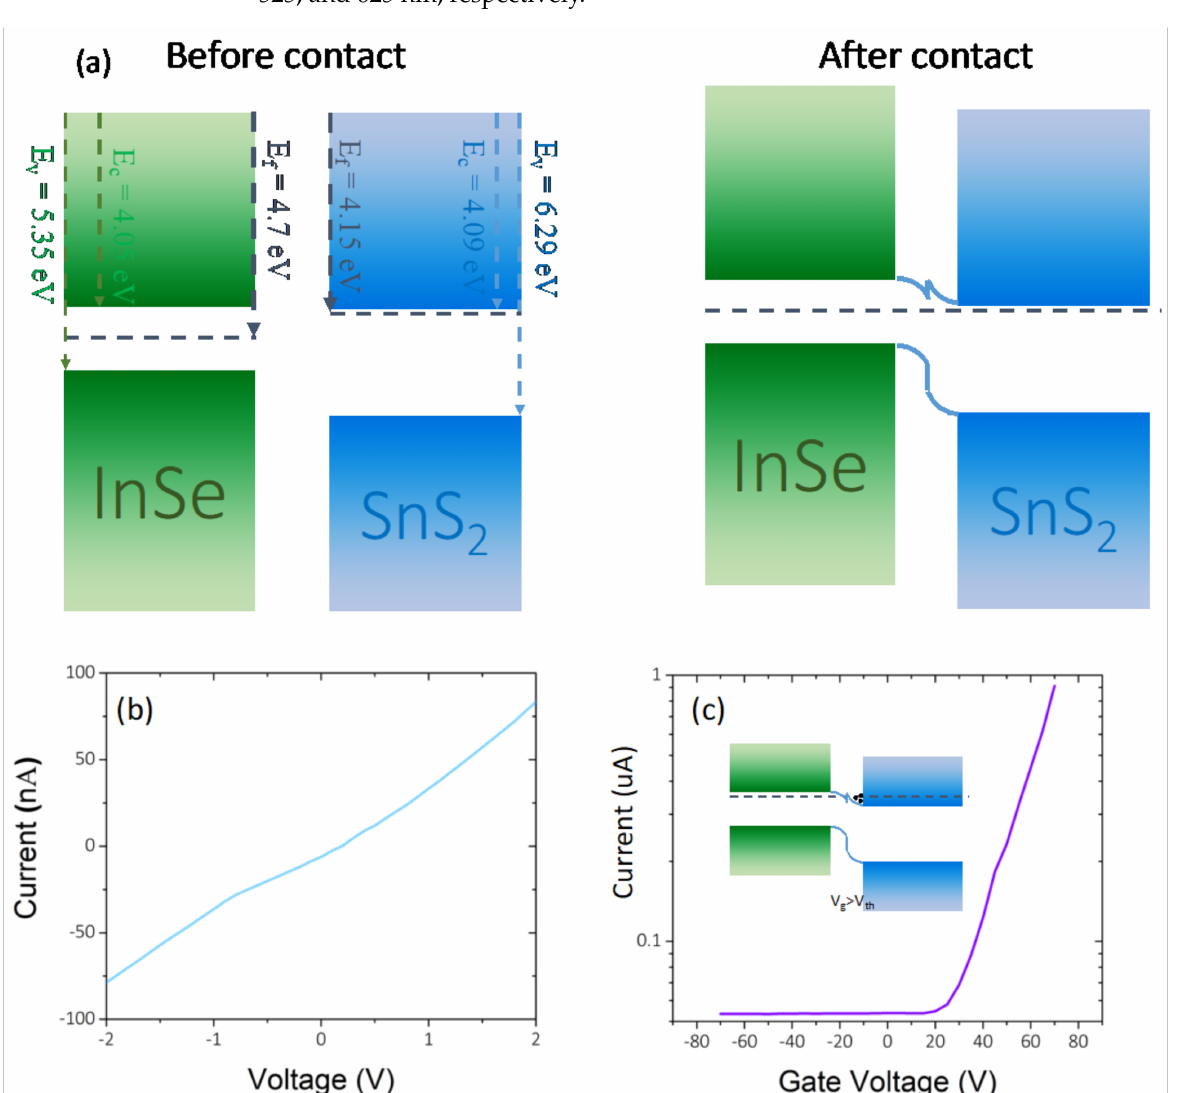
Figure 2. ( a ) Band diagram of SnS 2 /InSe heterostructure before and after contact, after contact, electron transfer from InSe to SnS 2 and hole transfer from SnS 2 to InSe (E f , E c , and E v are Fermi level, conduction band edge, and vallance band edge, respectively, The energy values are shown in figure). ( b ) Typical current-voltage curve of the device. ( c ) Drain current versus gate voltage of the device. Inset presents band diagram in positive gate